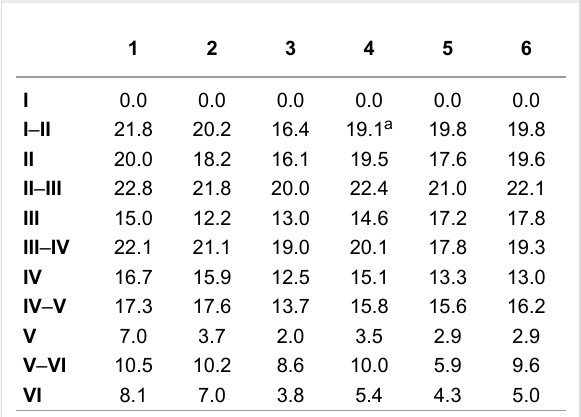
Table 1: Precatalyst initiation reaction pathway for catalysts 1 – 6 (M06/TZVP sdd//BP86/SVP sdd; Gibbs free energies in kcal/mol).